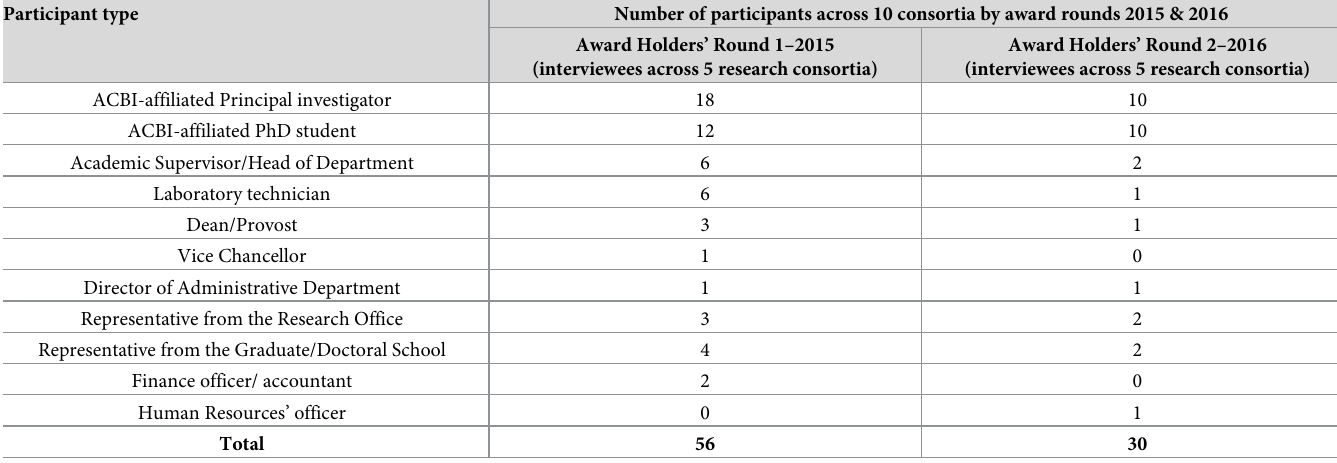
Table 1. Types of participants in in-depth